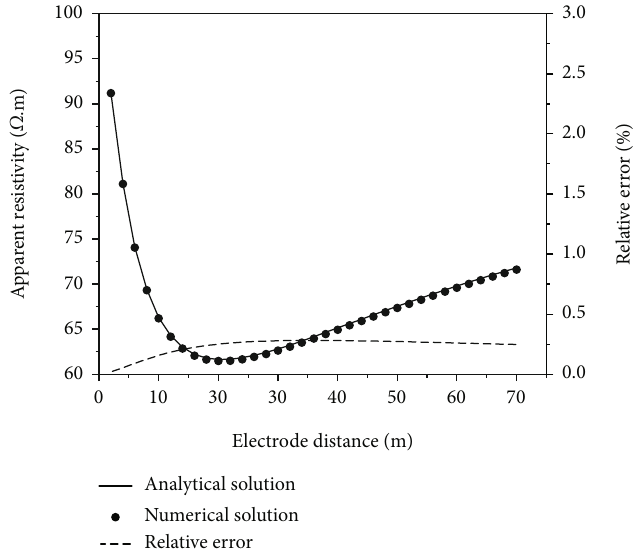
Figure 2: Comparison of the numerical solution and the analytical solution. The electrode distance represents the distance from the current source to the midpoint of two observed electrodes M and